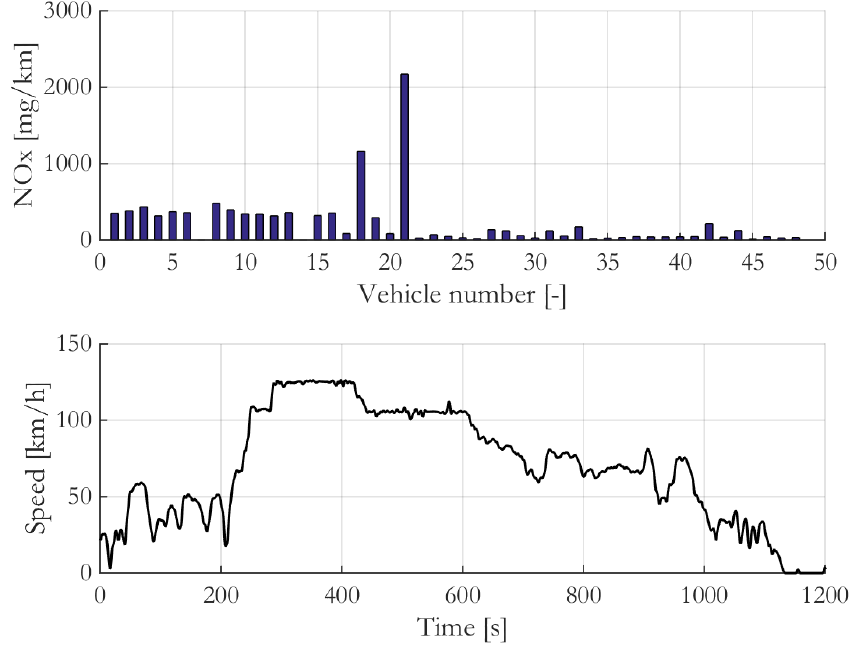
Figure 12. Example of NO x sensitivity to the vehicle, on the same real-world speed profile (i.e., same trip and same driver). Figure 13 shows histograms of errors in the estimation of NO x emissions, for more than 300 road links. In addition, 75% of the road-links have less than 100 mg/km error with the proposed model, compared to 30% with COPERT. The model mean of the mean absolute error is around 98 mg/km for the proposed model and 219 mg/km for COPERT. The mean absolute error is reduced by more than 55%. A similar error reduction is obtained for the CO 2 emissions. The proposed model has a mean absolute error of 21 g/km while it is around 45 g/km for COPERT. This represents respectively 12% and 25% of the mean CO 2 emissions for the recorded speed trajectories.